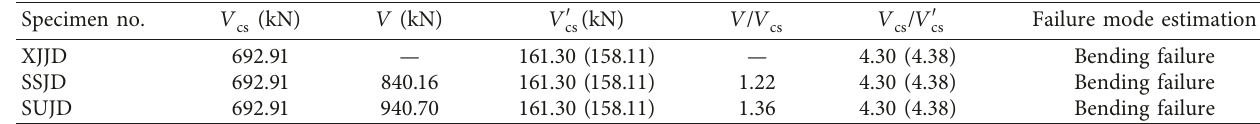
Table 3: Design values of the shear capacities of the